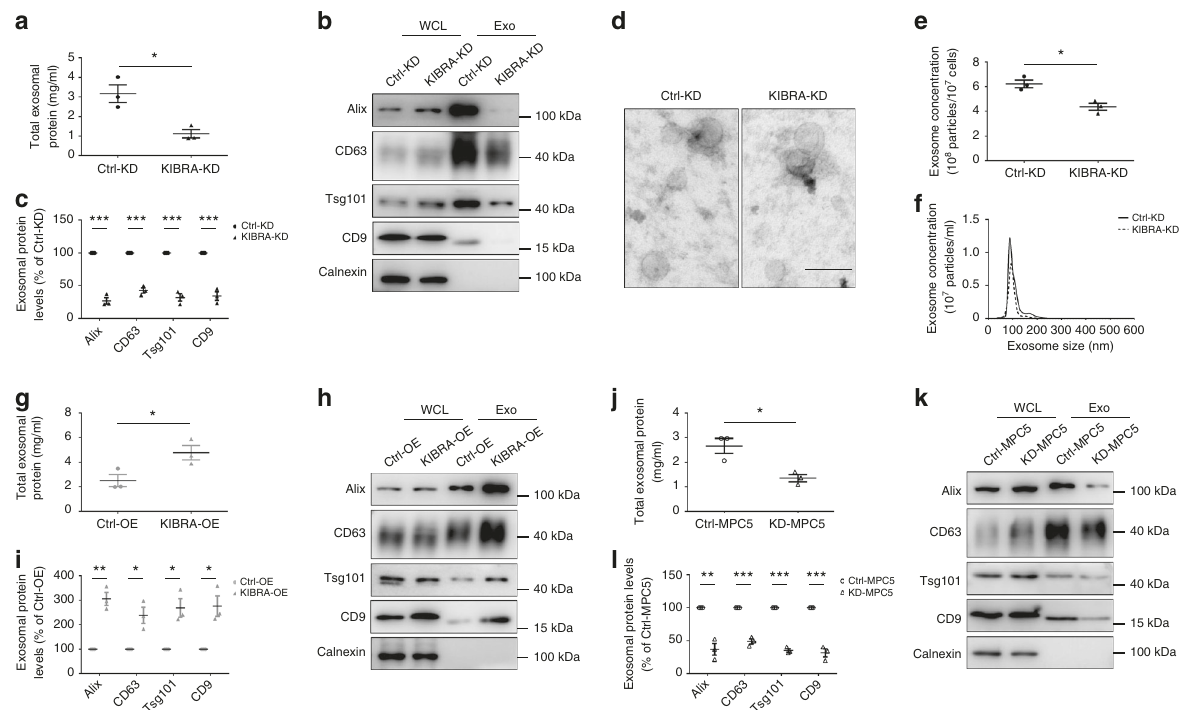
Fig. 1 KIBRA regulates secretion of small extracellular vesicles (EVs) in vitro. a Concentrations of exosomal proteins in KIBRA-KD and Ctrl-KD cells. Small EVs were isolated by serial ultracentrifugation from cell culture supernatants of 20 million cells and resuspended in 30 μ l lysis buffer. b Western blot analysis of small EVs puri fi ed by serial ultracentrifugation from cell culture supernatants from equal numbers of KIBRA-KD and Ctrl-KD cells. Whole cell lysates (WCL) and small EVs (Exo) were blotted for the exosomal markers Alix, CD63, Tsg101, and CD9 and for the endoplasmic reticulum marker Calnexin. c Quanti fi cation of exosomal protein levels in the small EVs obtained from KIBRA-KD and Ctrl-KD cells in three independent experiments. d Small EVs puri fi ed from cell culture supernatants were negatively stained and representative electron microscopic images were shown. Scale bar = 100 nm. e Quanti fi cation of nanoparticle tracking analysis (NTA) of three independent experiments. f Representative NTA traces of exosomes derived from KIBRA- KD and control cells, normalized to cell number. g Concentrations of exosomal proteins in KIBRA-OE and Ctrl-OE cells. Small EVs were isolated by serial ultracentrifugation from cell culture supernatants of 20 million cells and resuspended in 30 μ l lysis buffer. h Western blot analysis of EVs puri fi ed from equal numbers of KIBRA-OE and Ctrl-OE cells. i Quanti fi cation of exosomal protein levels in the EVs obtained from KIBRA-OE and Ctrl-OE cells in three independent experiments. j Concentration of exosomal proteins in Ctrl-MPC5 and KD-MPC5 cells. Small EVs were isolated by serial ultracentrifugation from cell culture supernatants of 20 million cells and resuspended in 30 μ l lysis buffer. k Western blot analysis of EVs puri fi ed from equal numbers of Ctrl- MPC5 and KD-MPC5 cells. l Quanti fi cation of exosomal protein levels in the EVs obtained from Ctrl-MPC5 and KD-MPC5 cells in three independent experiments. All quanti fi cation results were plotted as dot plots, showing the mean ± SE of three independent experiments. * P < 0.05, ** P < 0.01, *** P < 0.001 as determined by two-tailed t